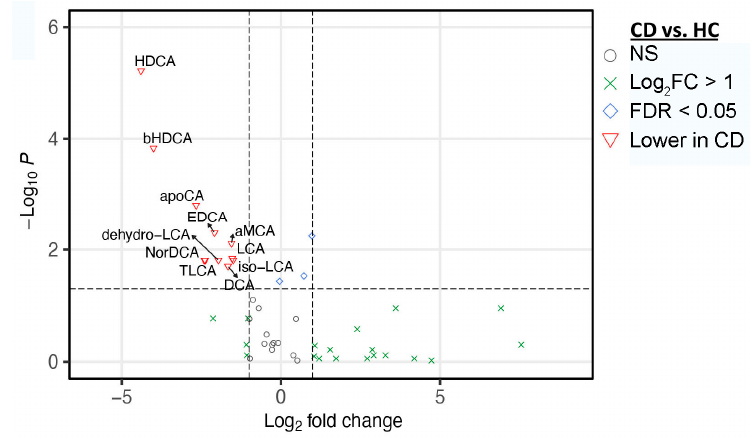
Figure 5. Significant differences in fecal BAs between CD and HC. Volcano plot represents the difference in fecal BAs between CD and HC at baseline. Statistical significance was determined using the two-tailed Mann Whitney U–test with FDR < 0.05 and fold difference > 2.0. HC, healthy controls; CD, Crohn’s disease; FDR, false discovery rate; HDCA, α -hyodeoxycholic acid; bHDCA, β -hyodeoxycholic acid; apoCA, apocholic acid; EDCA, 3-dpideoxycholic acid; aMCA, α -muricholic acid; LCA, lithocholic acid; dehydro-LCA, dehydrolithocholic acid; isoLCA, isolithocholic acid; DCA, deoxycholic acid; NorDCA, 23-nordeoxycholic acid; TLCA, taurolithocholic acid.